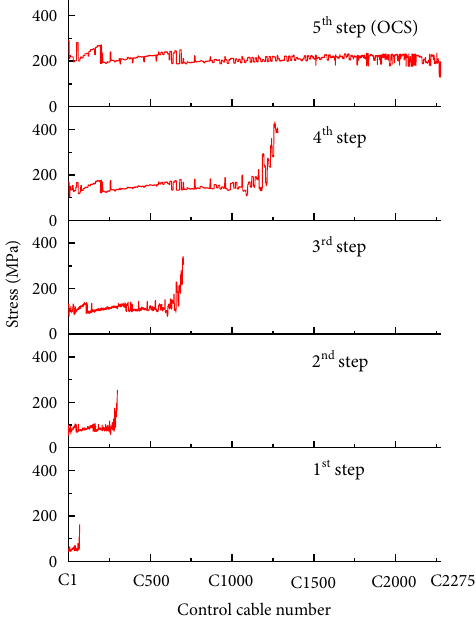
Figure 11. Stress distribution of control cables for different tensioning stages